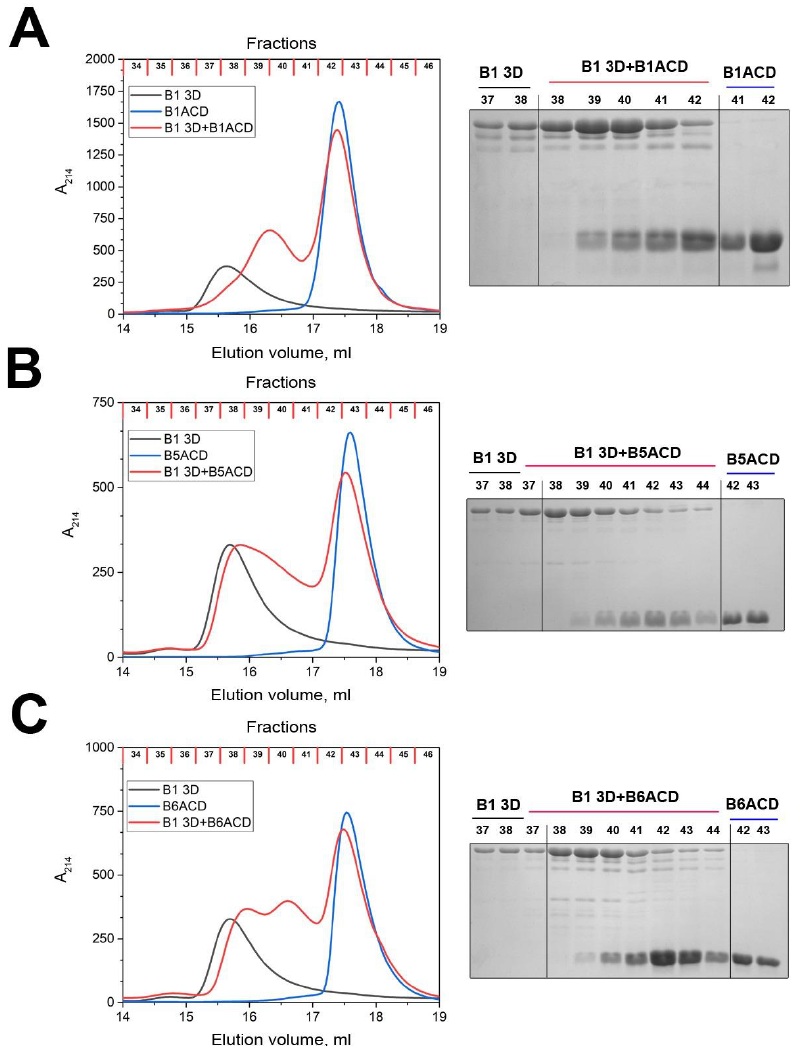
Figure 5. Interactions of ( A ) B1ACD, ( B ) B5ACD and ( C ) B6ACD with a 3D mutant of HspB1. Elution profiles of the isolated 3D mutant (black lines), isolated ACDs (blue lines) and their equimolar mixture (red lines) on a Superdex 200 Increase 10/300 column. The protein compositions of fractions collected during each chromatography run (no less than three runs) and determined by SDS–PAGE are presented on the